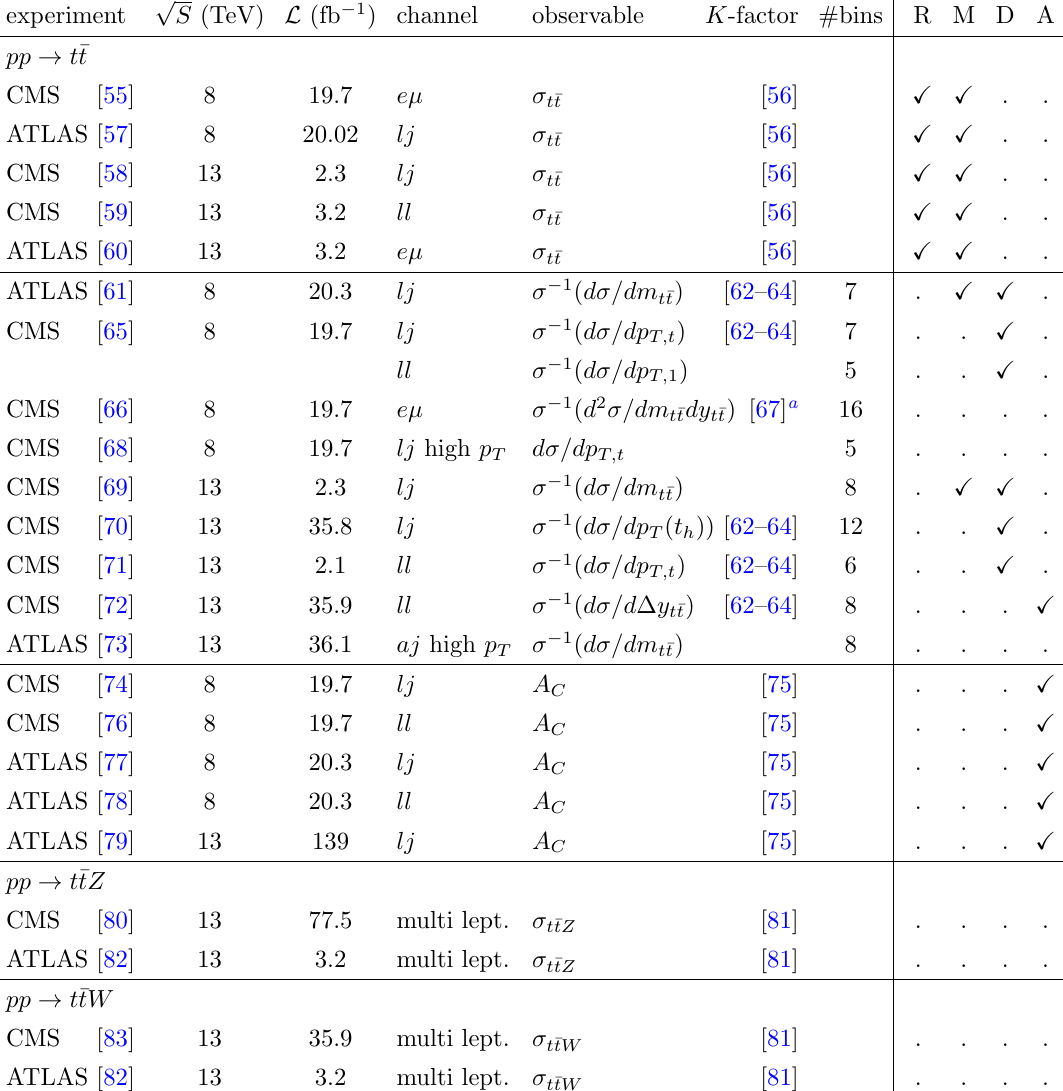
Table 5 . Top-pair observables included in our global analysis. The labels R, M, D, A de(cid:12)ne four di(cid:11)erent data sets with rates, rates and invariant mass distributions, distributions only, and asymmetries, used in the numerical analysis of section